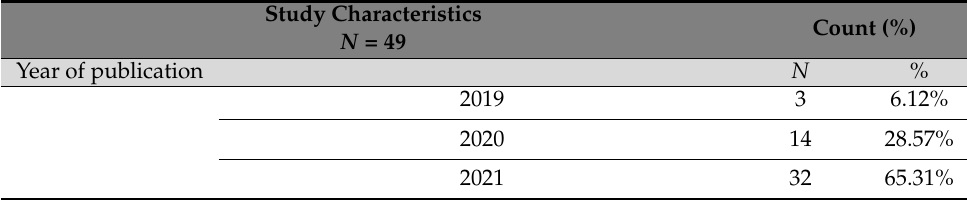
Table 1. Included studies